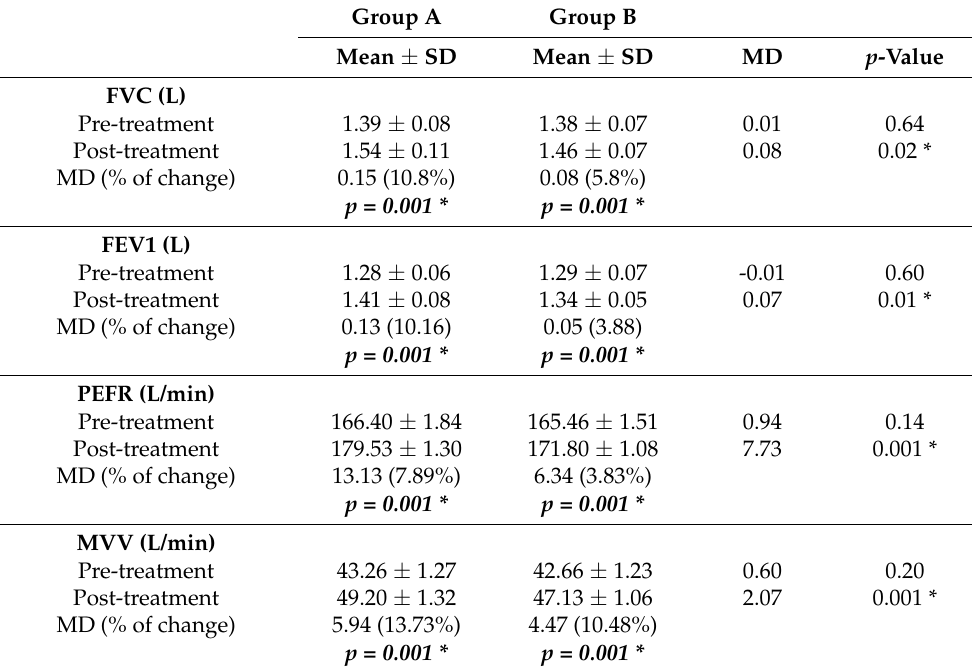
Table 2. Pulmonary function measures of pre- and post-treatment of both groups.